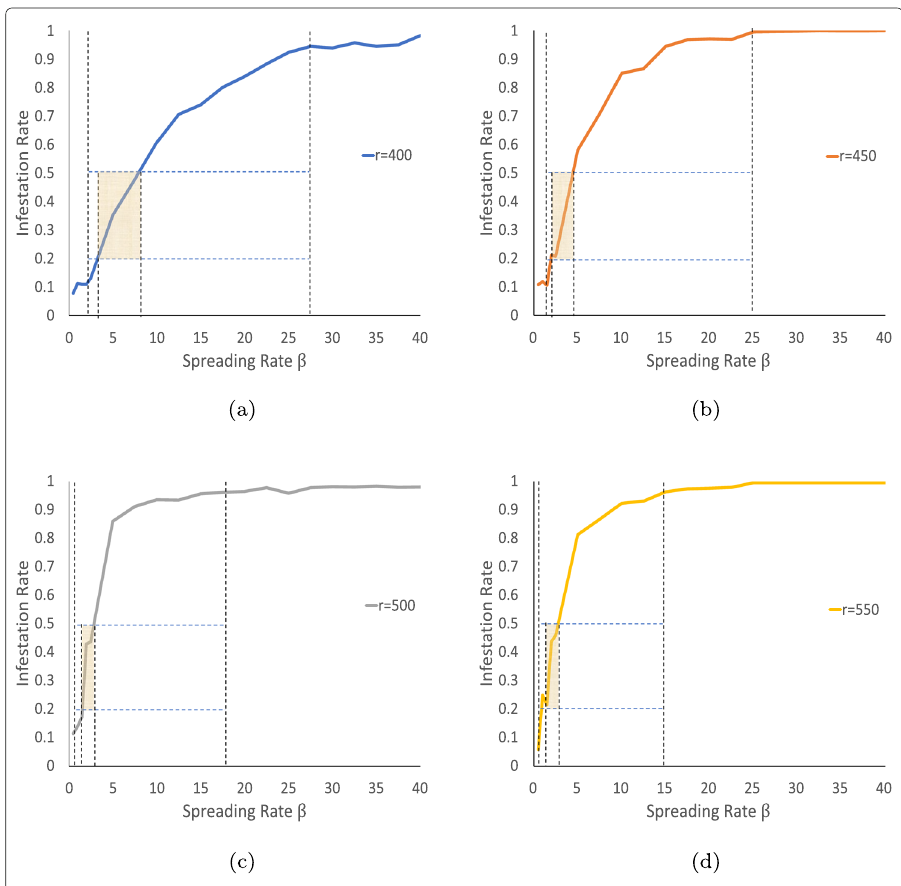
Fig. 4 Tulsa Phase Change Diagrams for 4 Migration Radii. The three phases are indicated by high dotted dividing lines. The true spreading rate β is unknown. If true infestation rates fall within 20% to 50%, the range of possible real-life β values is shown by the shaded region. a r = 400. b r = 450. c r = 500. d r = 550